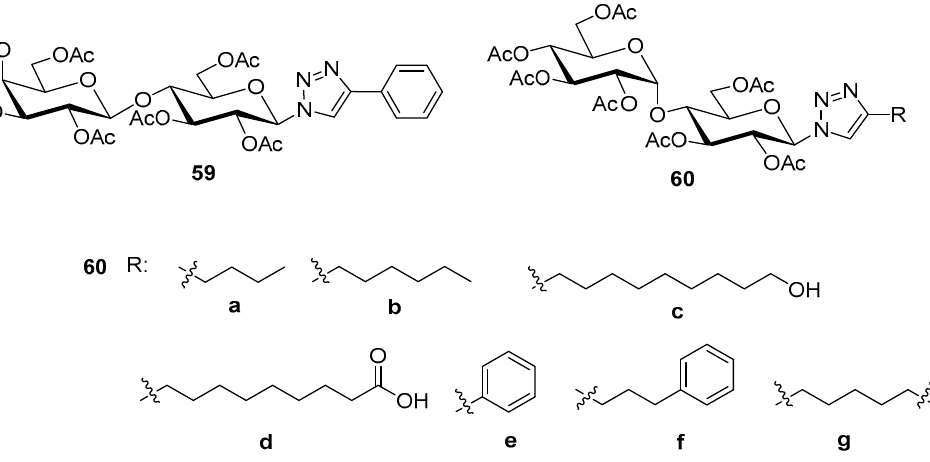
Figure 39. Structures of peracetylated lactosyl and maltosyl triazole derivatives